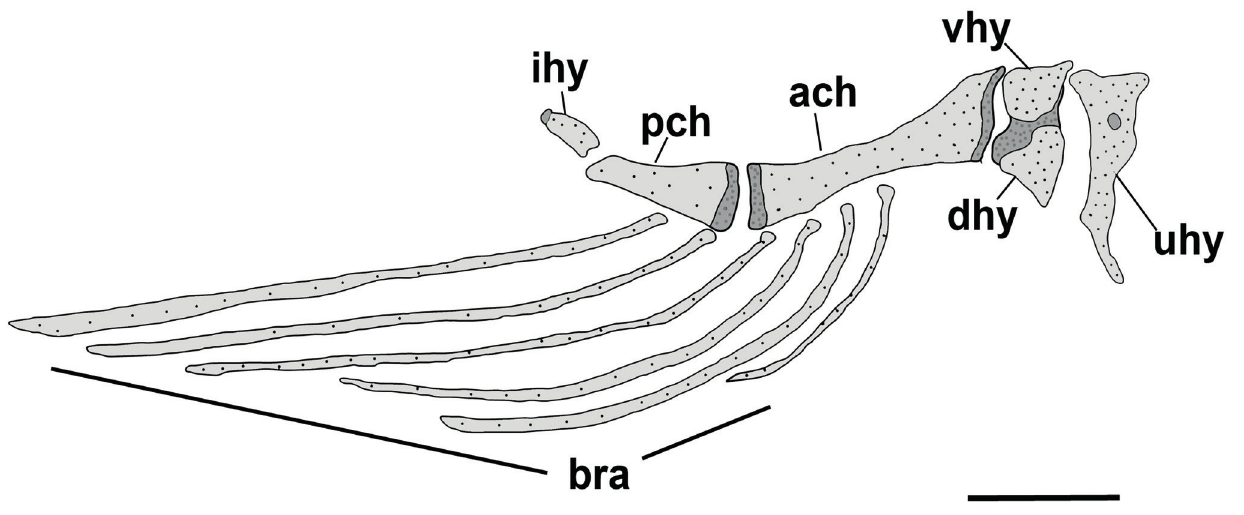
FIGURE 4 | Right hyoid arch of Tatia akroa , MZUSP 44071, 26.0 mm SL. Ventral view. Abbreviations: ach , anterior ceratohyal; bra , branchiostegal rays; dhy , dorsal hypohyal; ihy , interhyal; pch , posterior ceratohyal; vhy , ventral hypohyal; uhy , urohyal. Scale bar = 1 mm.